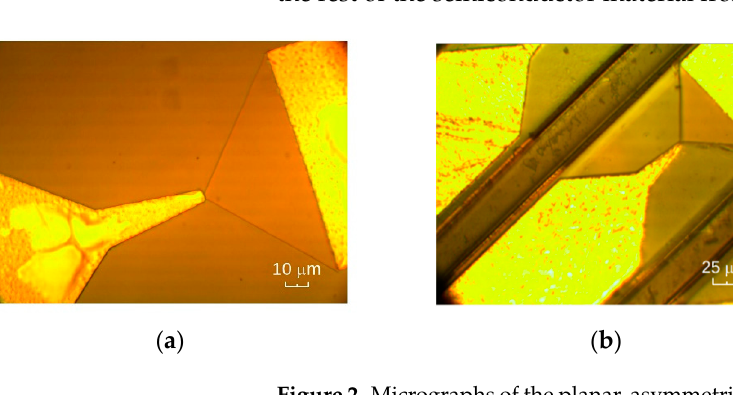
Figure 2. Micrographs of the planar, asymmetrically necked microwave diodes ( a ) on a semiconductor substrate; ( b ) on polyimide film (view from the polyimide film side); ( c ) on polyimide film (view from the side of metallic contacts).